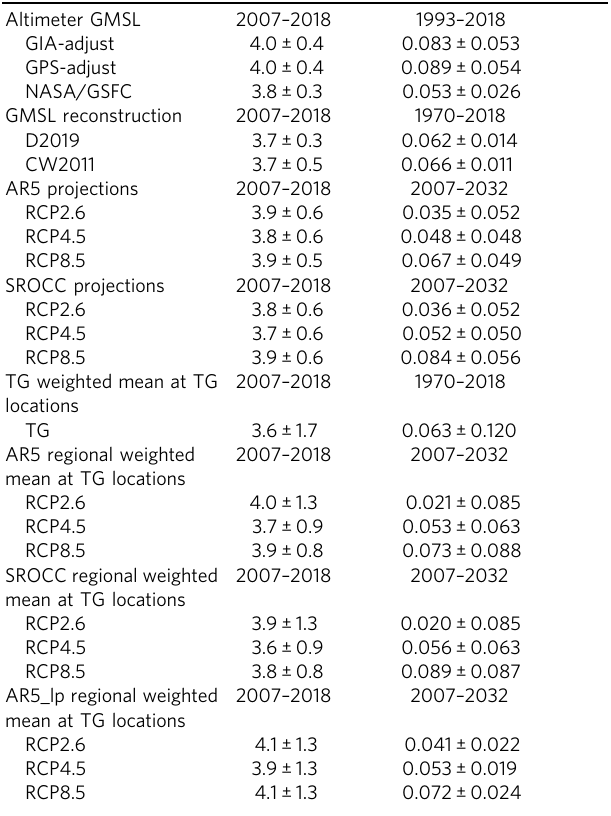
Table 1 Comparison of observed trends and accelerations with those from